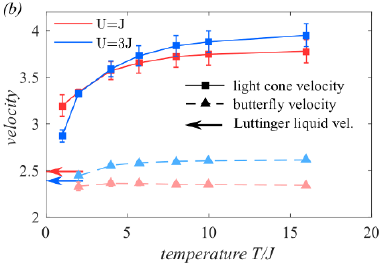
Figure 5 . Butter(cid:13)y velocity v B as a function of temperature T=J for di(cid:11)erent coupling U=J . This plot is taken from